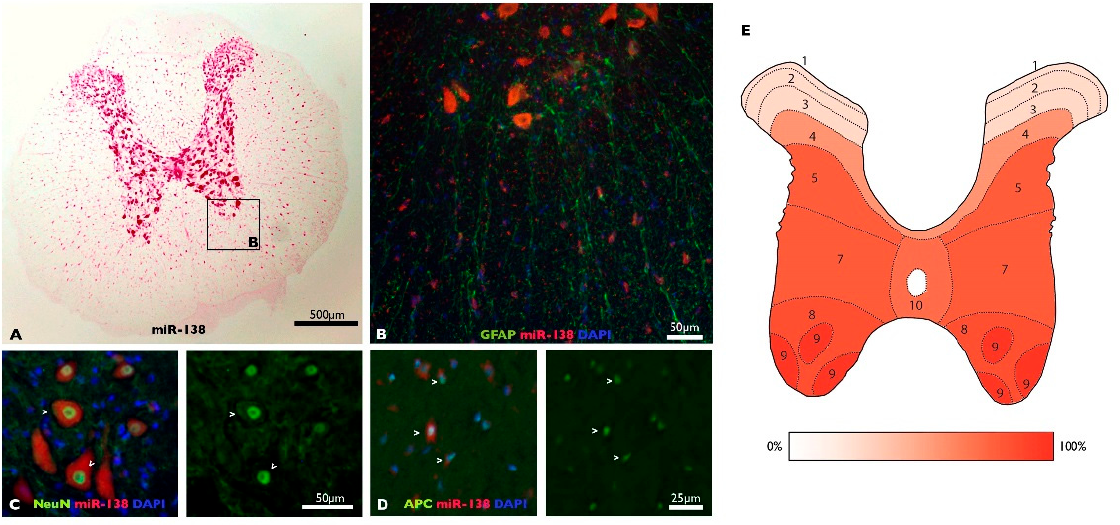
Figure 1. MiR-138-5p expression in the undamaged spinal cord: ( A ) Representative image of miR- 138-5p expression (pink) in a transverse section of the thoracic spinal cord. ( B – D ) Co-staining of GFAP (astrocytes, ( B ), NeuN (neurons, ( C ) and APC (oligodendrocytes, ( D ) cell markers (green) with miR-138-5p probe (red) in spinal cord sections. ( E ) Map of the Rexed laminae in the T9 spinal segment detailing the mean percentage of miR-138-5p positive neurons present in each lamina of the naive spinal cord (7 sections from 2